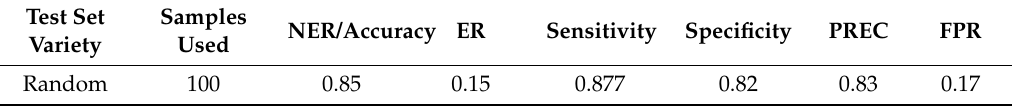
Table 2. Classification parameters obtained from unknown (test) data set after applying the model. Test Set Samples NER/Accuracy ER Sensitivity Specificity PREC FPR Variety Used Random 100 0.85 0.15 0.877 0.82 0.83